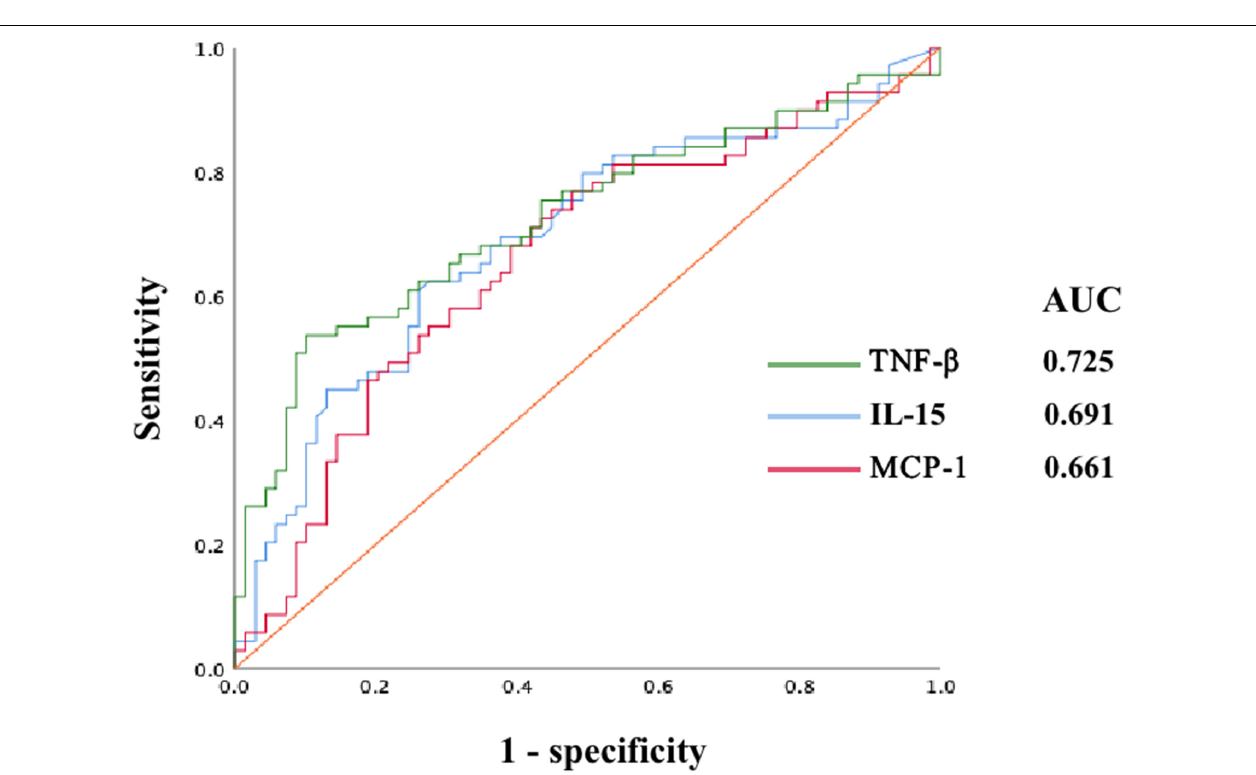
FIGURE 4 | The receiver operator characteristic (ROC) curve of serum TNF- β , IL-15, and MCP-1. AUC, area under the curve; IL-15, interleukin 15; MCP-1, monocyte chemoattractant protein-1; TNF- β , tumor necrosis factors- β .